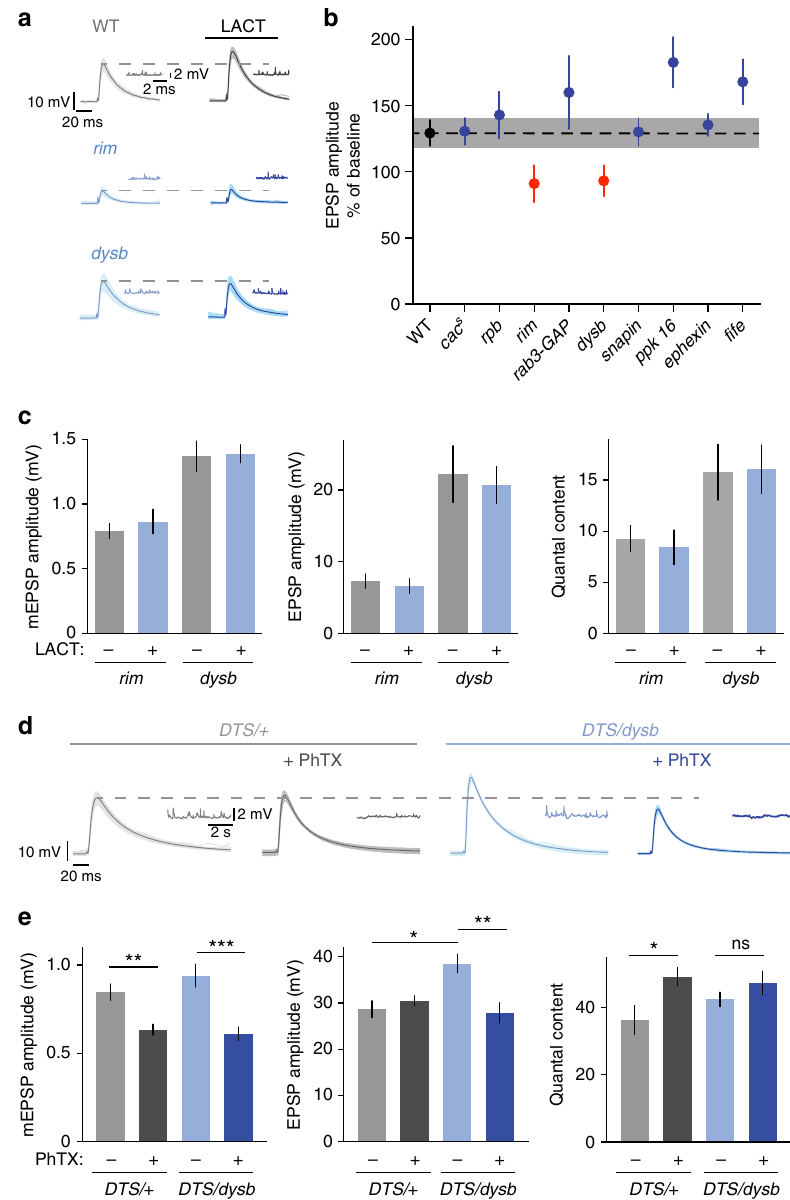
Fig. 7 rim and dysbindin are required for proteasome-dependent potentiation. a Application of 100 µ M lactacystin for 15 min to wild-type synapses and selected PHP mutants. Representative EPSP and mEPSP traces are shown for wild type, rim and dysbindin mutants. b For quanti fi cation, EPSP amplitude after lactacystin application was normalized to the EPSP amplitude at baseline. Wild-type EPSPs show an increase to 130% upon lactacystin treatment. The PHP mutants cac s , rim-binding protein ( rbp ), rab3-GAP , snapin (presynaptic RNAi), pickpocket16 ( ppk 16 ), ephexin and fi fe show similar or stronger increases, whereas rim and dysbindin ( dysb ) mutants do not respond to lactacystin treatment. Due to defects in baseline EPSP amplitude in some of the genotypes, different [Ca 2+ ] e concentrations were used to adjust baseline EPSP amplitudes to comparable values: WT: 0.3 mM; cac s : 0.5 mM; rbp : 1 mM; rim : 0.3 mM; rab3-GAP : 0.3 mM; dysbindin : 0.3 mM; snapin RNA i : 0.3 mM; pickpocket 16 : 0.25 mM; ephexin : 0.25 mM; fi fe : 0.3 mM. Mean ± s.e.m.; n ≥ 8 cells. c Quanti fi cation of mEPSP amplitude, EPSP amplitude and quantal content of rim and dysbindin mutant synapses at baseline and after lactacystin application (100 µ M for 15 min). Mean ± s.e.m.; n ≥ 10 cells. d Synapses expressing one allele of the mutant proteasome subunit presynaptically either in a wild-type background ( DTS/ + ; het) or in larvae mutant for one allele of dysbindin ( DTS/dysb ; double het) were measured under baseline conditions and after application of 20 µ M PhTX for 10 min (0.3 mM [Ca 2+ ] e ). Representative EPSP and mEPSP traces are shown. e Quanti fi cation of mEPSP amplitude, EPSP amplitude and quantal content for the experiment described in ( d ). DTS /+heterozygous synapses have no defect in PHP, whereas DTS/dysb double heterozygous synapses show no increase in quantal content after PhTX application. * p < 0.05, ** p < 0.001; *** p < synapses also signi fi cantly reduced cumulative EPSC amplitudes recruitment of EGTA-sensitive vesicles. Application of EGTA- compared to untreated NMJs overexpressing dysbindin (Supple- AM to synapses overexpressing venus- dysbindin resulted in a mentary Fig. 5e). These results suggest that dysbindin over- signi fi cant decrease in EPSC amplitude (Fig. 8f, g), similar to the expression potentiates release from an EGTA-sensitive vesicle decrease seen after EGTA-AM application to DTS pre synapses (Fig. 5). EGTA-AM treatment of dysbindin -overexpressing pool.